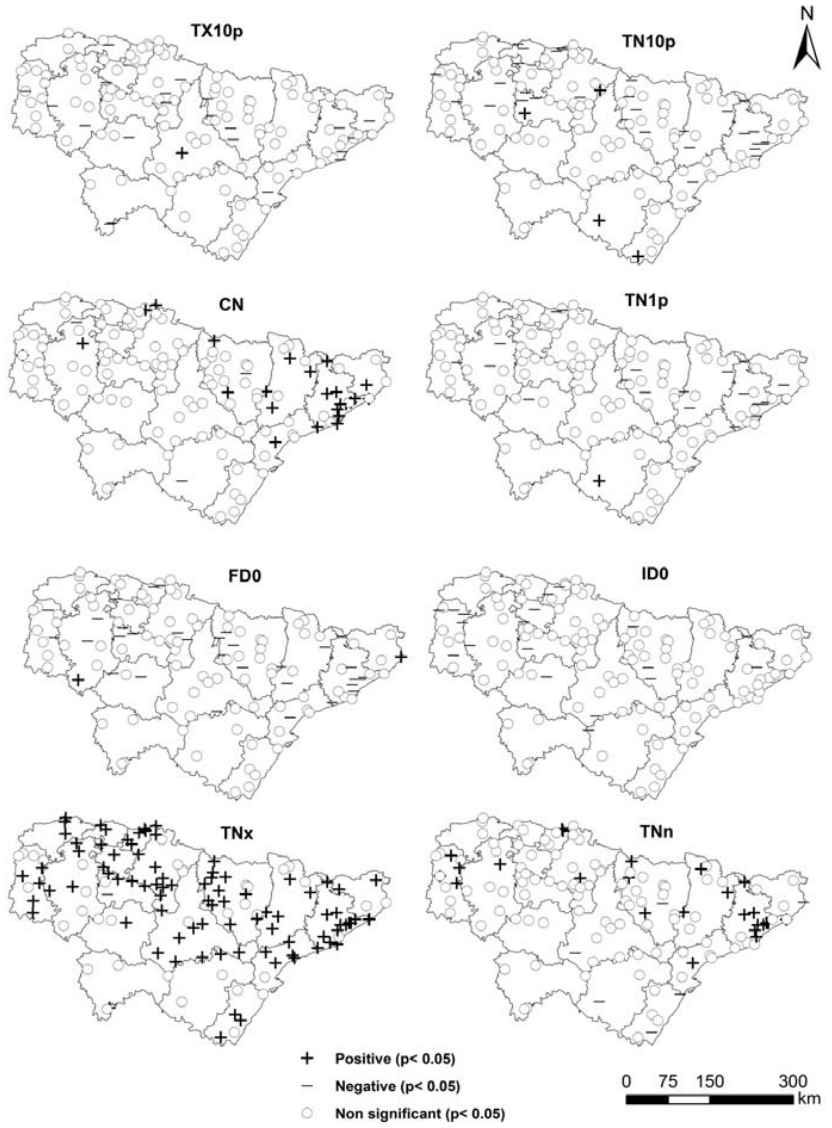
Figure 8. The same as Figure 5, but for cold extreme indices. Fig. 8. The same as Fig. 5, but for cold extreme